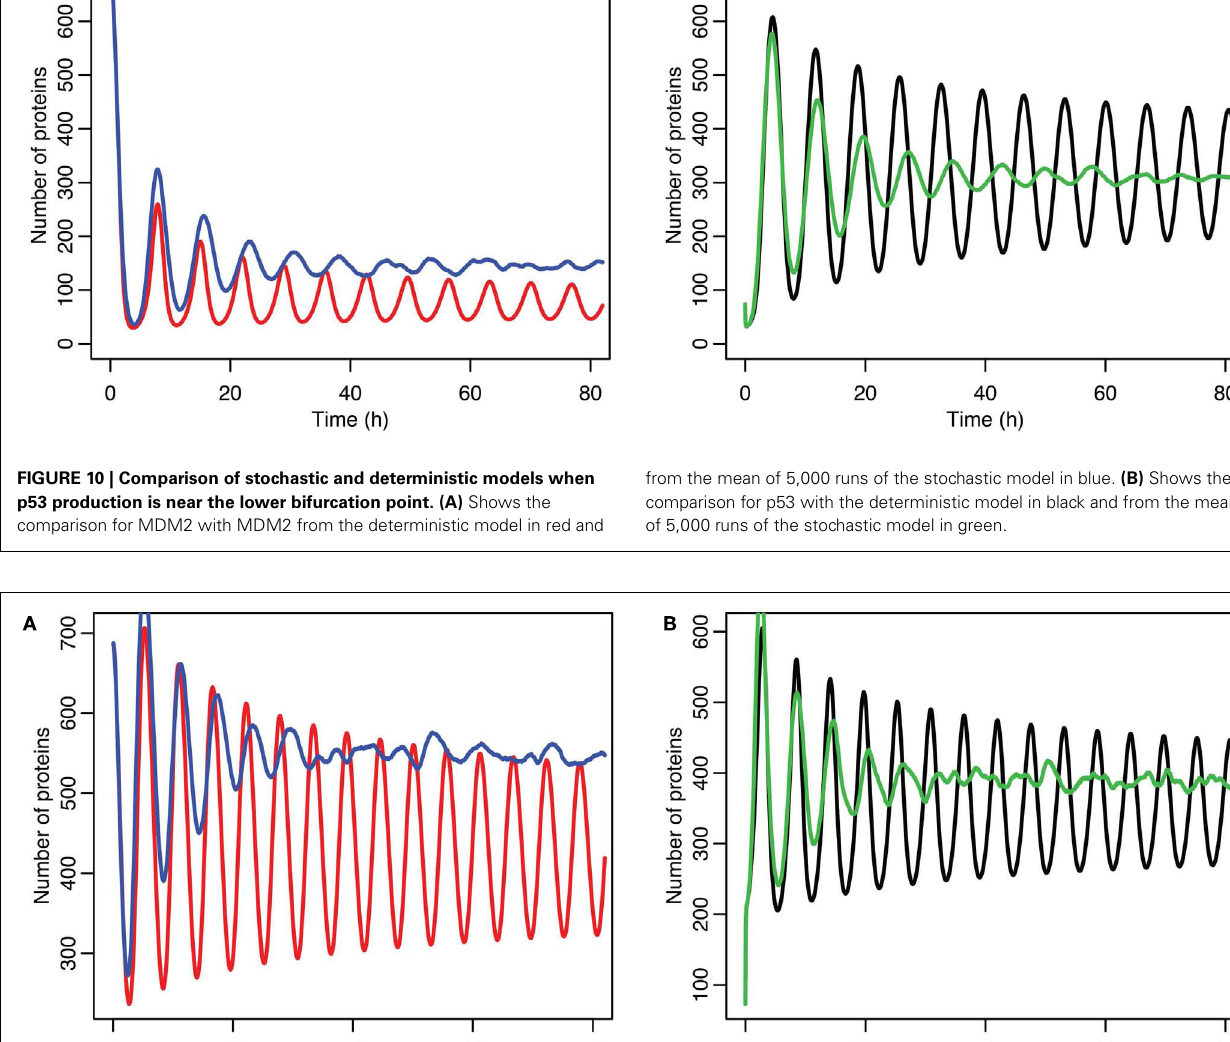
from the mean of 5,000 runs of the stochastic model in blue. ( B ) Shows the comparison for p53 with the deterministic model in black and